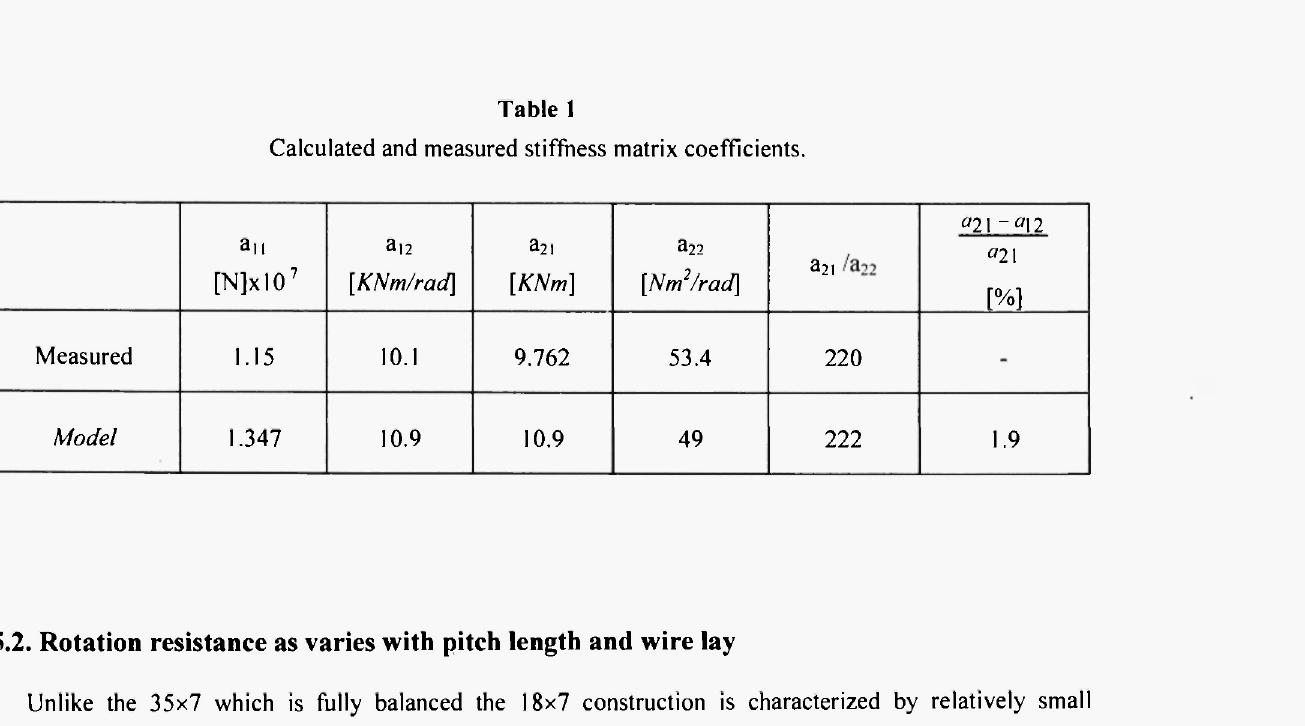
Calculated and measured stiffness matrix